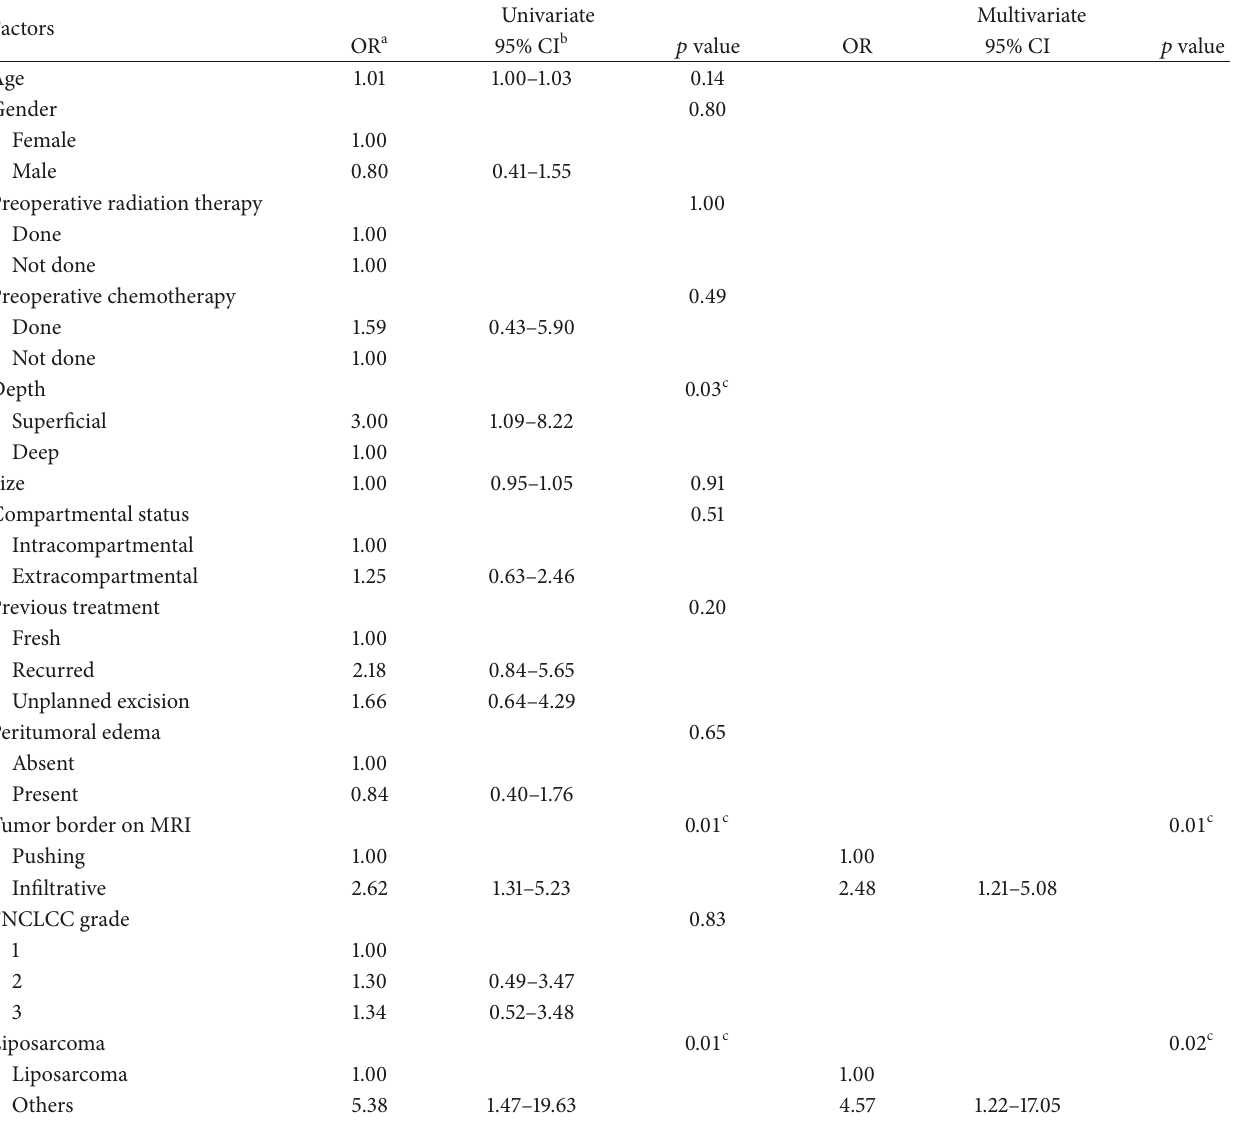
Table 3: Preoperative factors associated with histological growth